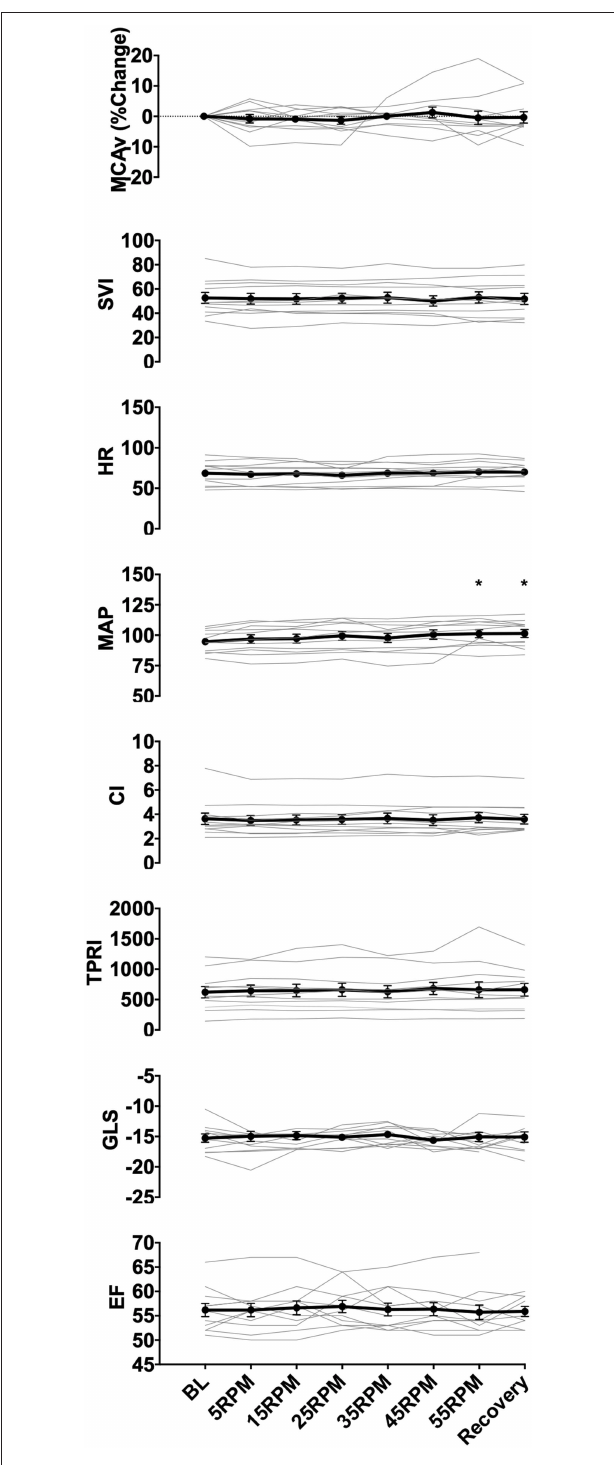
FIGURE 2 | Group data showing changes in middle cerebral artery blood flow velocity (MCAv), SVI, heart rate (HR), MAP, cardiac index (CI), total peripheral resistance index (TPRI), GLS, and ejection fraction (EF) with increasing cycling cadence. Average values across all subjects for all measured parameters are illustrated by the data points, with error bars representing the standard error of